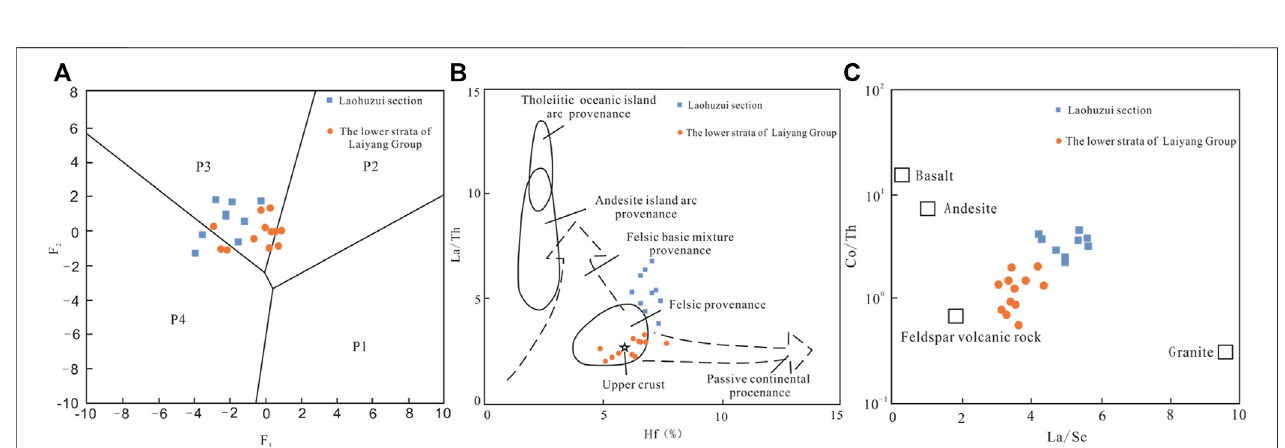
FIGURE8| Identi fi cationofprovenanceintheLaohuzuisection. (A) Mainelementprovenancediscriminantplot,theF1andF2computingmethodandthe fi eldsof differenttectonicsettingsarefromRoserandKorsch(1988). (B) La/Th – Hfplotfortheprovenanceofthesiltstone,afterFloydandLeveridge(1987). (C) Co/Th – La/Scplot for the provenance of the siltstone, after Gu et al. (2002).